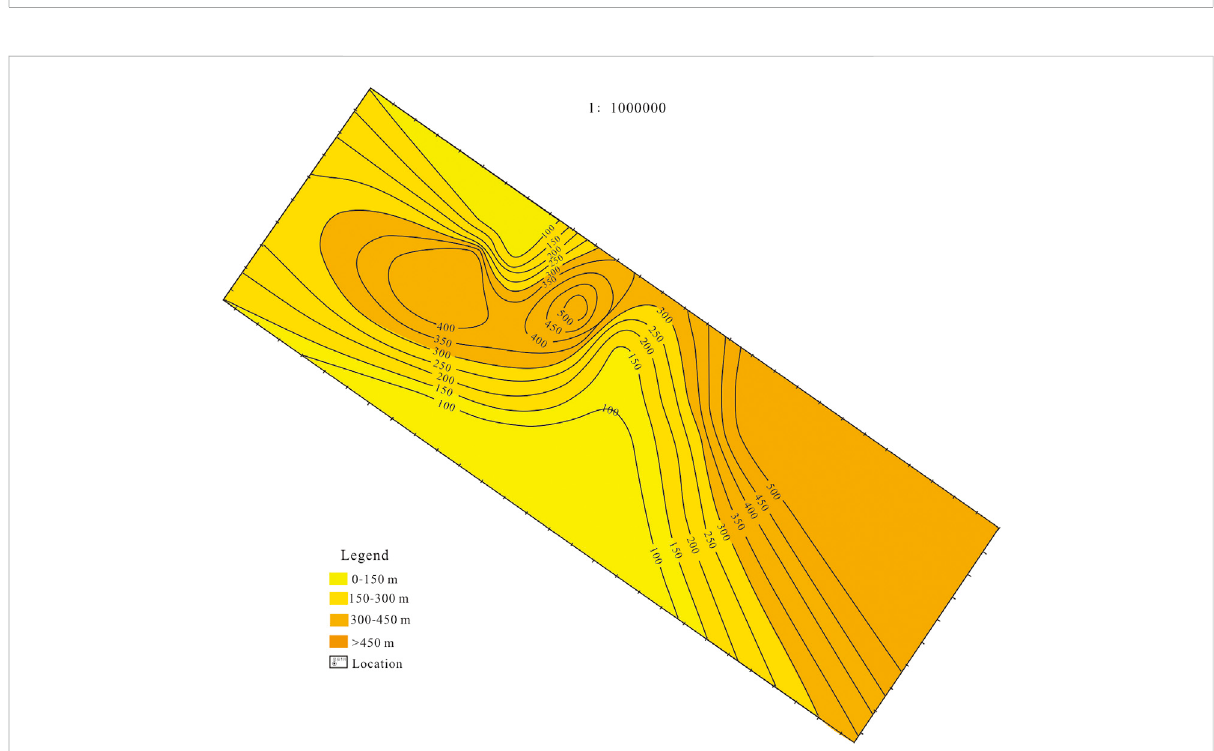
FIGURE 4 Thickness of the hydrocarbon source rocks in the upper part of the Lucaogou